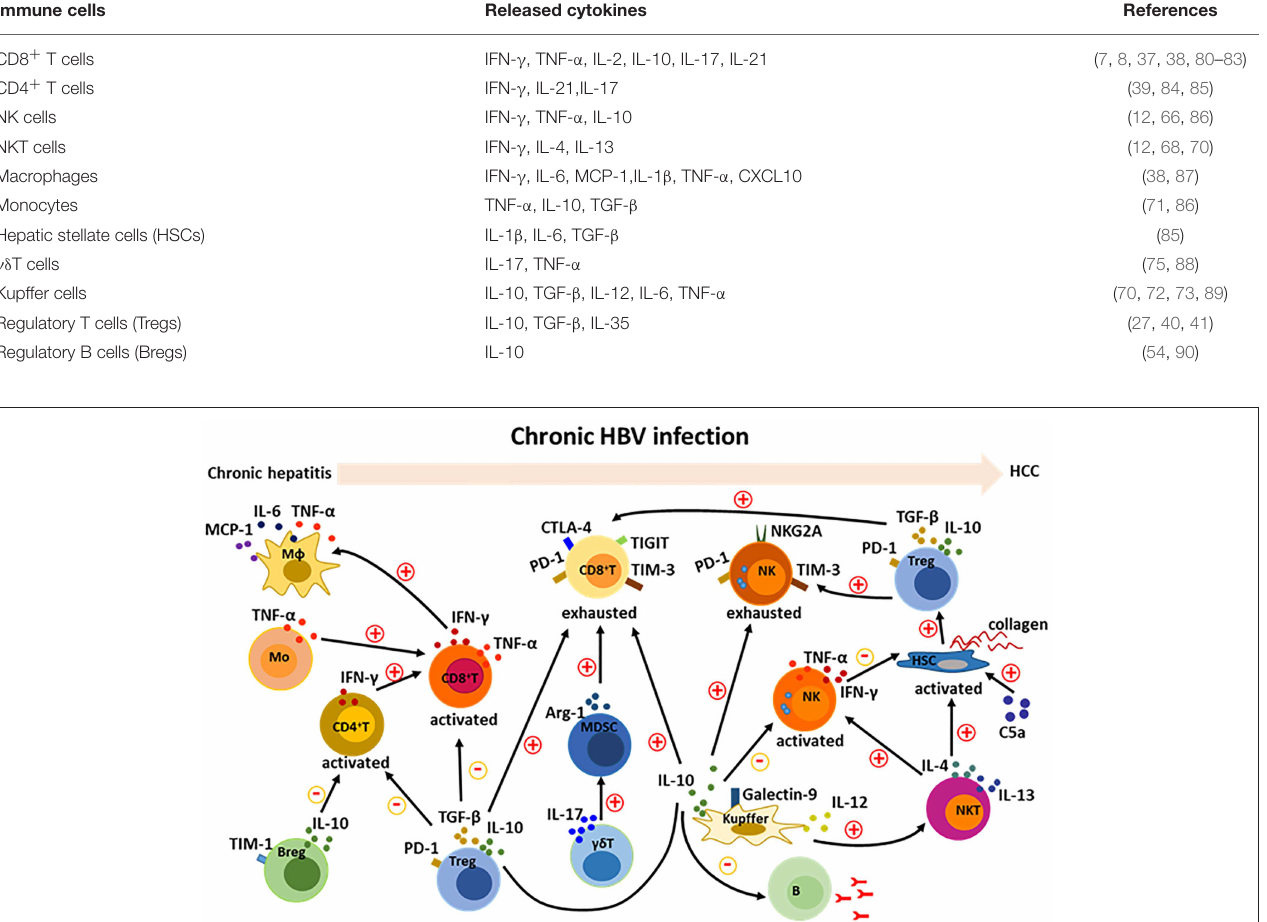
TABLE 1 | HBV-induced changed immune cells and released cytokines. Immune cells